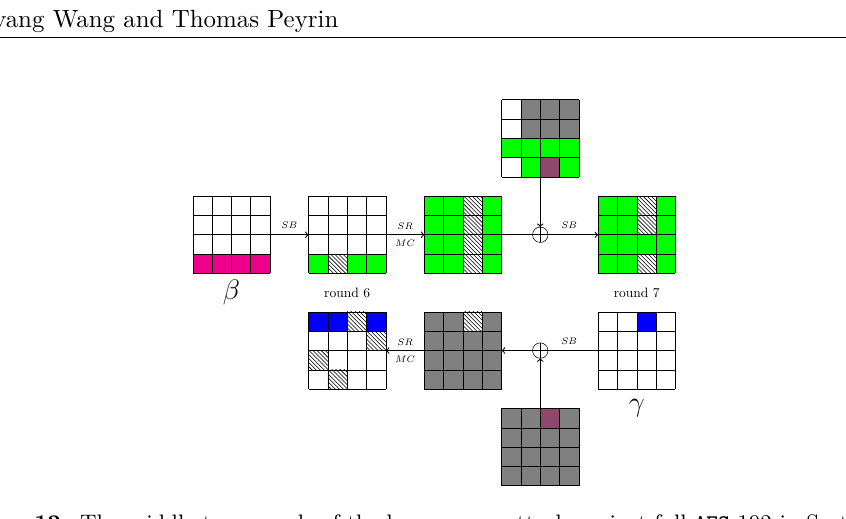
Figure 12: The middle two rounds of the boomerang attack against full AES -192 in Section 5.1. The differences of the bytes marked with slash are not